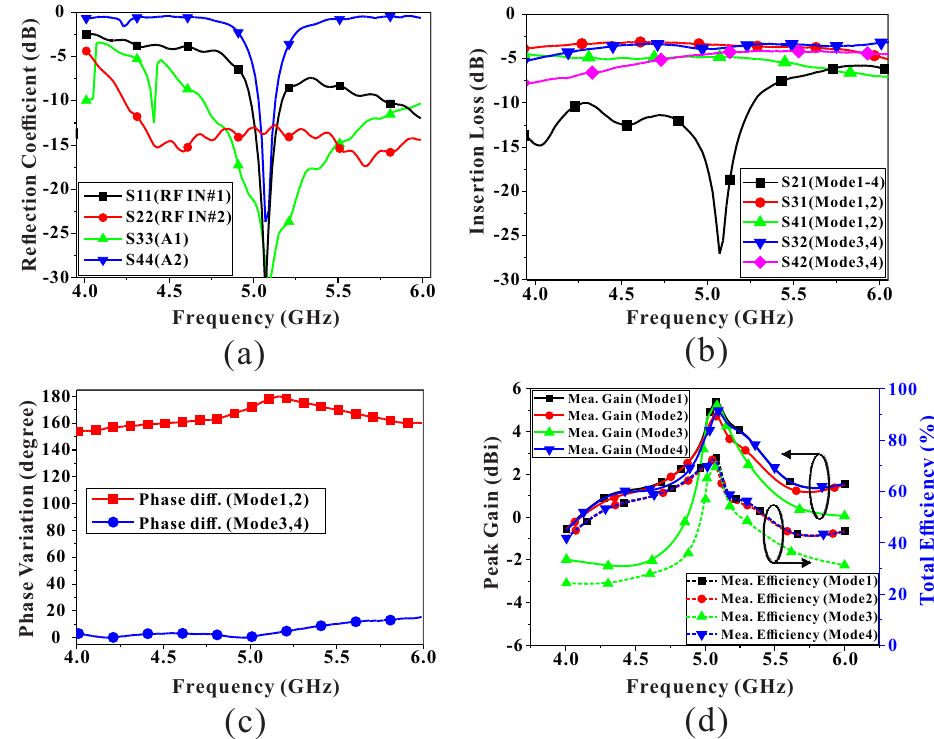
Figure 4. Performance of the proposed multi-antenna system with regard to the input modes (1–4): ( a ) measured reflection coefficients, ( b ) measured insertion loss, ( c ) measured phase variations with regard to the RF INs, and ( d ) measured peak gain and total